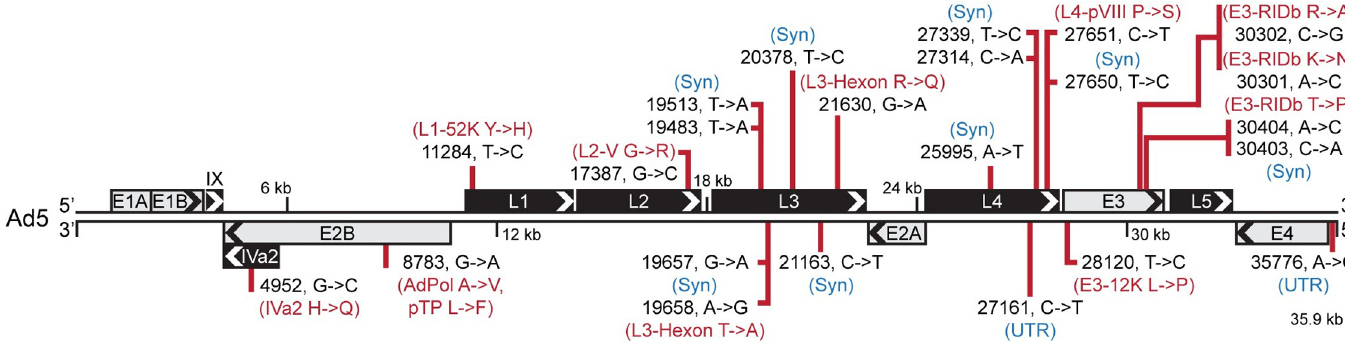
Fig 1. RNA-seq reveals high-confidence SNPs within the Ad5 genome. The 35,938 base pair linear genome of Ad5 is displayed in the traditional left to right format. Major transcriptional units are shown as boxes above or below the genome with arrowheads denoting the orientation of the open reading frames (ORFs) encoded within. Grey boxes denote early gene transcriptional units while black boxes denote late genes. Bcftools was used to analyze short-read RNA seq data to predict single nucleotide polymorphisms (SNPs) and insertions/deletions (InDels) that approach 100% of the RNA reads when compared to the reference Ad5 genome (AC_000008). In total, 24 such SNPs were discovered and their positions within the genome is highlighted by red vertical lines. For each SNP, the nucleotide position as well as the top strand reference base and corrected base are shown in black text (nucleotide position, reference base - > corrected base). If indicated SNPs fell within untranslated regions (UTR), or did not change the encoded amino acid of any annotated reading frame potentially impacted by the SNP, these were marked with blue text denoting either UTR or Syn (synonymous mutation), respectively. For any SNP that led to an amino acid change within an annotated ORF, these ORFs as well as the identity of the reference amino acid and corrected amino acid are highlighted in